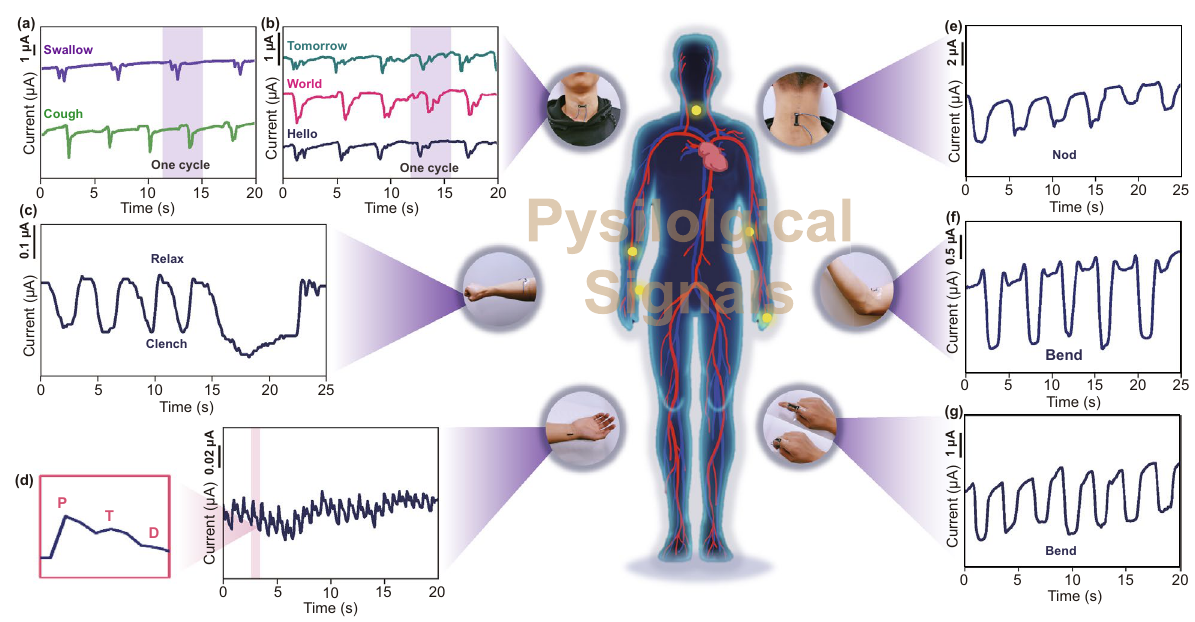
Fig. 5 a Current response to the swallow and cough by attaching the strain sensors on the throat. b Voice and speech recognition by attaching the strain sensors on throat near the vocal cord. c Detection of holding–loosing the fist by attaching the strain sensors on the arm. d Real-time monitoring of the radial artery pulse by attaching the strain sensors to the wrist. The enlarged image (left) is single cycle of radial artery pulse wave form including “P”, “T” and “D” peaks. e Detection of nod by attaching the strain sensors to the posterior neck. f Detection of elbow bend by attaching the strain sensors to the joint of elbow. g Detection of finger bend by attaching the strain sensors to the